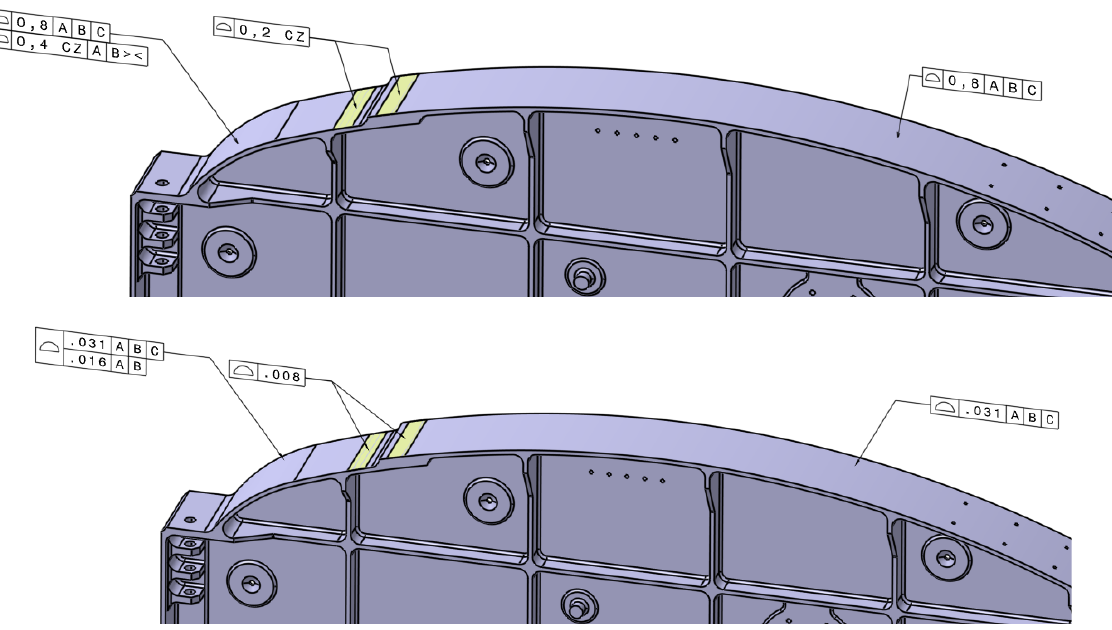
Figure A10. Upper flange in ISO model ( top illustration) Upper flange in ASME model ( bottom illustration).